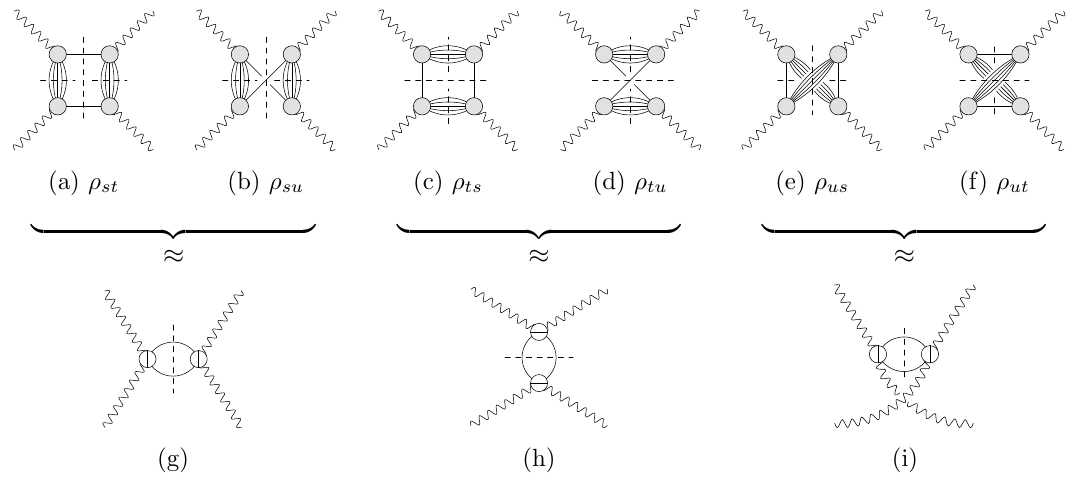
Figure 9. (a){(f) Unitarity diagrams representing the complete set of \2disc"-box contributions. (g){(i) Partial-wave approximation: the sub-process becomes a polynomial in the crossed